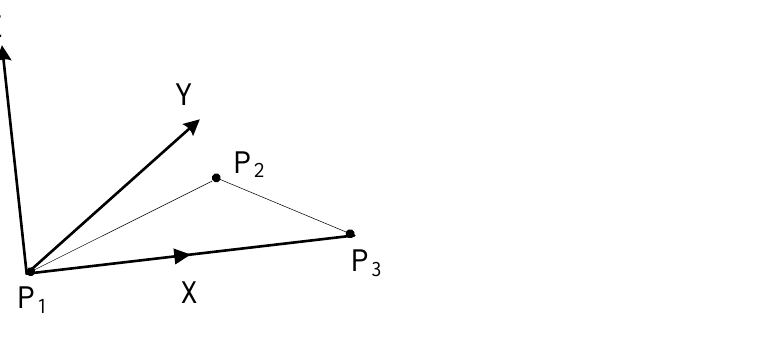
Figure 2. Construction of an object coordinate system based on points P 1 , P 2 , and P 3 specified in the WCS : the X axis is determined by points P 1 P 3 , the Z axis is normal to the plane of the P 1 P 2 and P 1 P 3 vectors, and the Y axis is normal to the ZX plane.